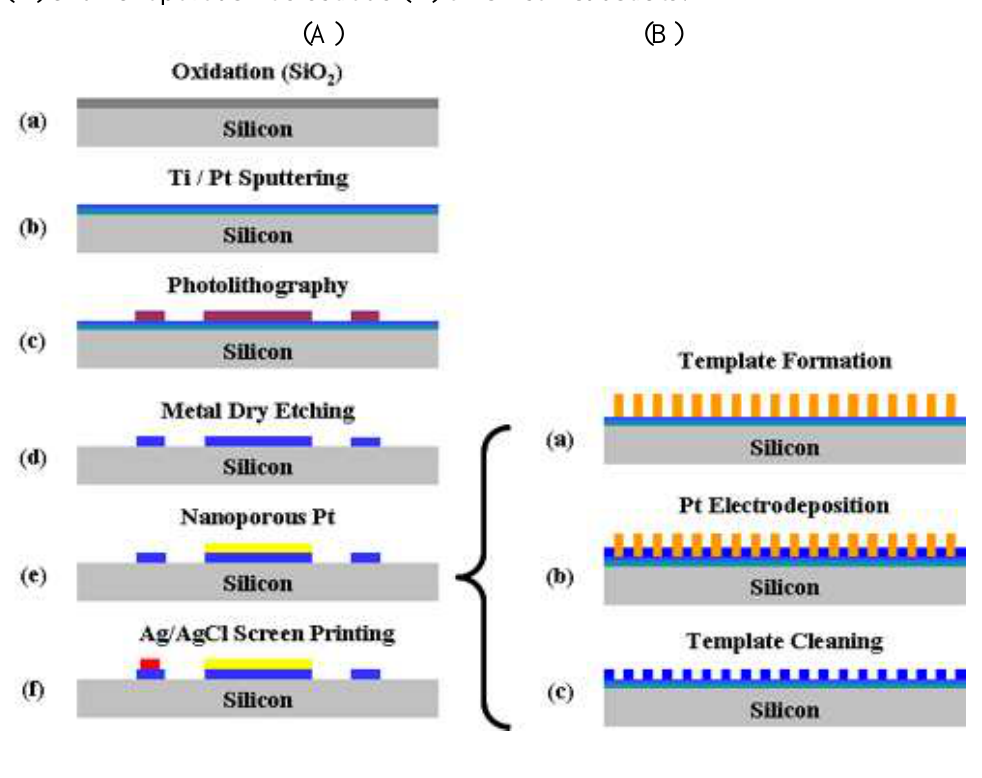
Figure 2. Fabrication procedures of non-enzymatic glucose micro-sensor with nanoporous Pt WE ( A ) and nanoporous Pt electrode ( B ) on silicon substrate.